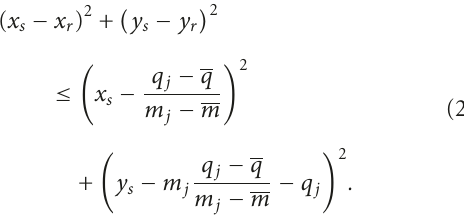
Figure 6: Tracing paths in the visibility diagram: the parameters of the outgoing ray are found by means of the intersection of the dual of the beam (a segment) and of the receiver (a line). Paths falling in beams limited by a reflector, also (2) must